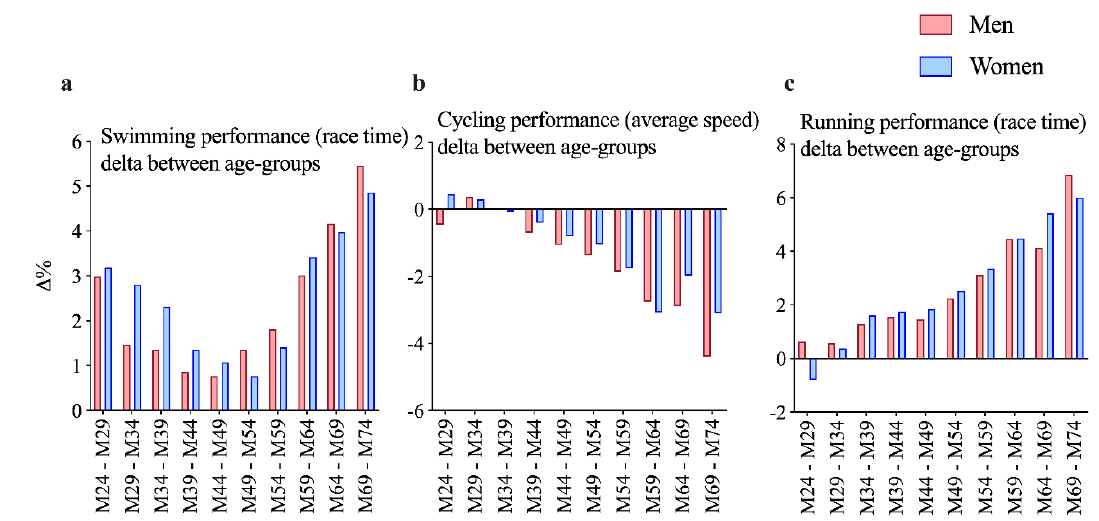
Figure 2. Split performance delta (%) between any two adjacent age groups; ( a , on the left): swimming speed (km/h); ( b , in the middle): cycling average speed (km/h); and ( c , on the right): running speed (km/h); ( a – c ): men in red, women in blue.